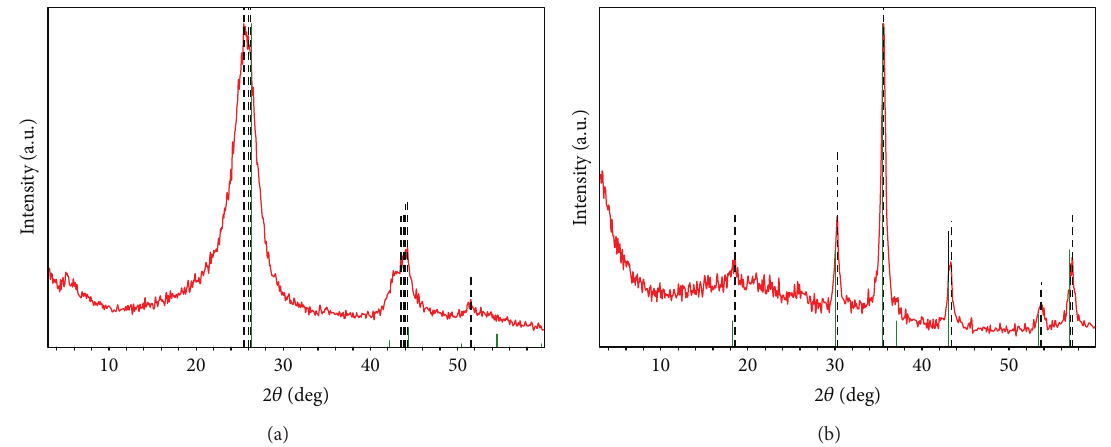
Figure 5: XRD patterns of (a) oxidized MWCNTs with HNO 3 and (b) HMNPs.